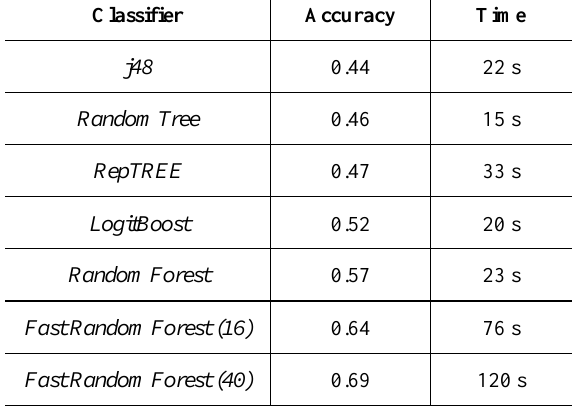
Table 1: Accuracy results and elapsed time for various classifier applied to an orthoimage at 1:20